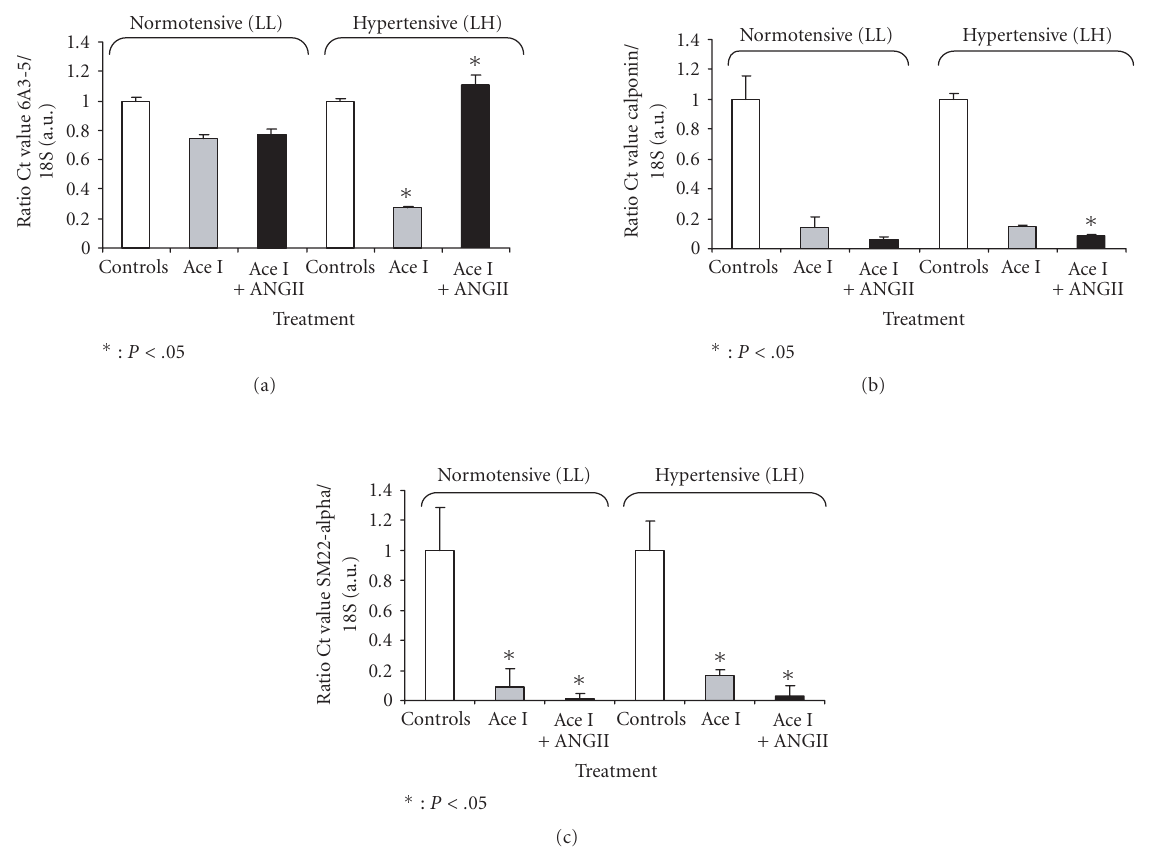
Figure 10: Expression of 6A3-5/Osa2 and vascular phenotype in ACE inhibitor treated LH and LL rats . (a) 6A3-5/Osa2 aortic mRNA expression in untreated LH and LL rats (controls) was compared to ACE inhibitor treated rats in the absence (Ace I) or presence of perfused ANGII (Ace I + ANGII). 6A3-5/Osa2 gene expression is downregulated by the ACE inhibitor and upregulated by exogenous AngiotensinII in LH rats. (b) Calponin gene expressions were quantified in these same animals. (c) SM22 alpha gene expressions were also quantified in these same animals. Results are indicated as a ratio of 6A3-5/Osa2 mRNA expression in comparison to 18S expression. Data are presented as means ± SEM . ∗ : P < . 05 versus controls untreated rats, for each